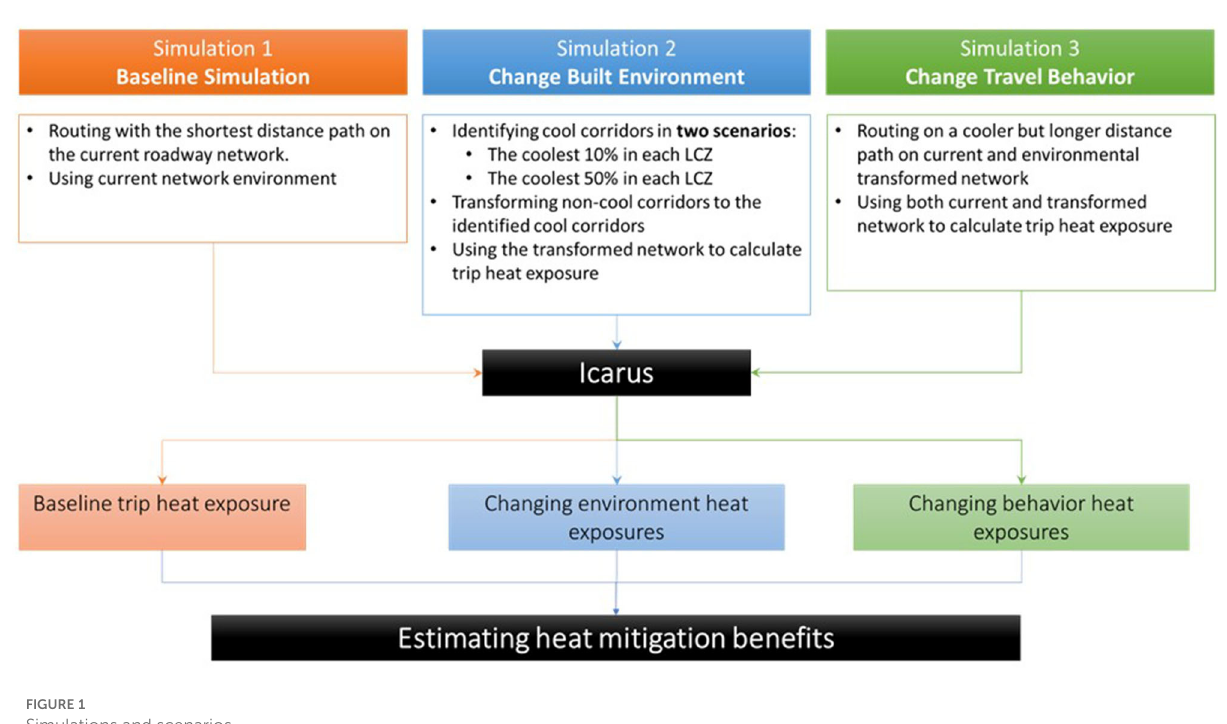
FIGURE1 Simulations and